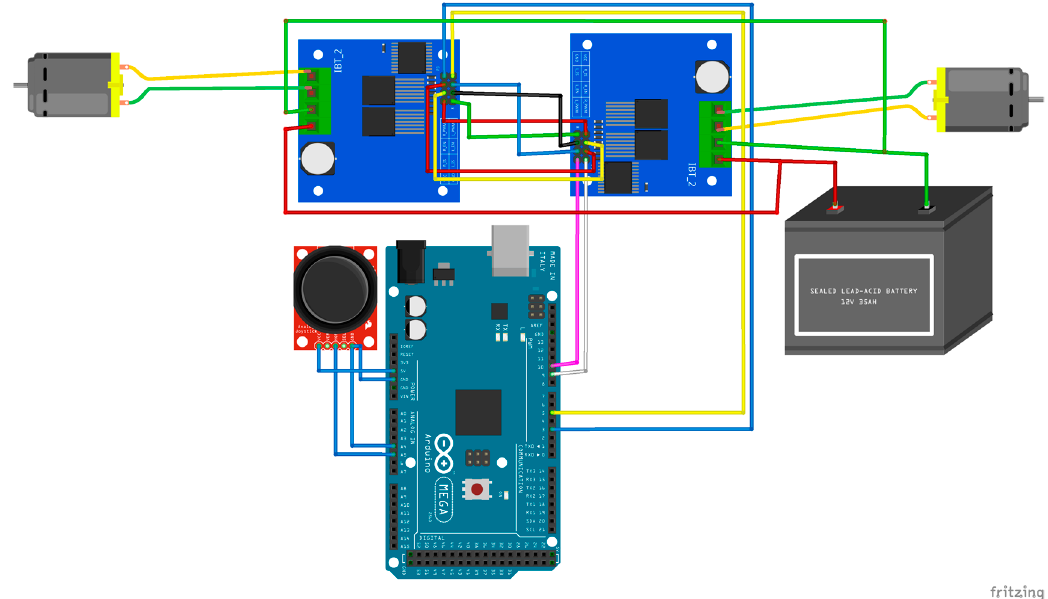
Figure 1. Joystick Control of motors to navigate a wheelchair.